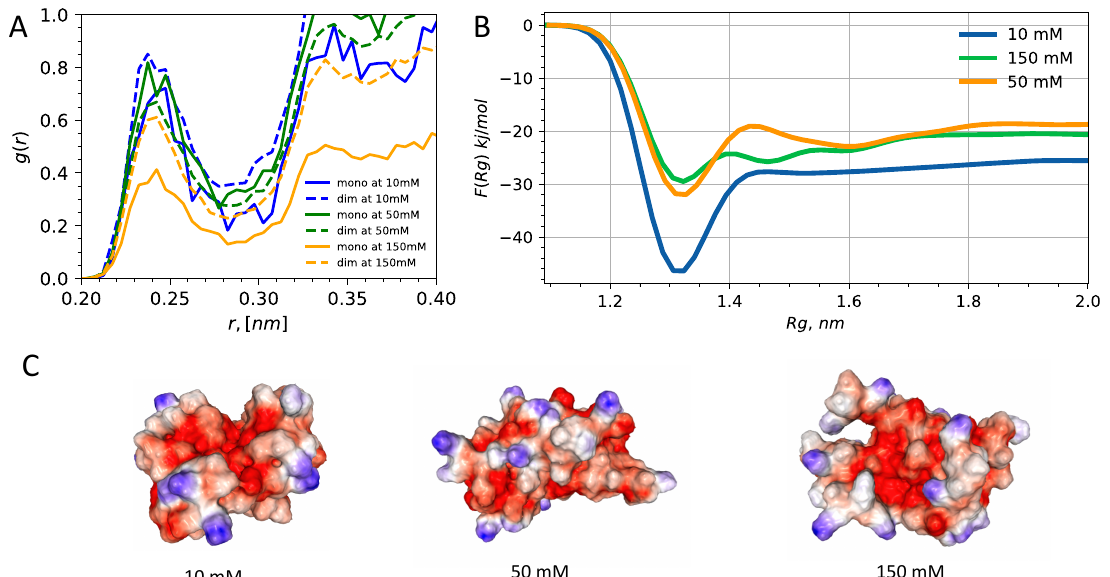
Figure 6. Ionic condensation and free energy profiles of dimerization as a direct measure of HP1a condensation affinity. ( A ) radial distribution function of ion-residue pairs with ions being defined as pair − I ( Na + and Cl − ) and centers of mass of residues being defined as pair − II . ( B ) Free energy as a function of radius of gyration of fuzzy dimers under 10 mM, 50 mM and 150 mM ionic conditions. ( C ) Showing electrostatic surface representations of averaged conformation sampled from states in the vicinity of the free energy minima. Colormap binds positive to blue and negative to red